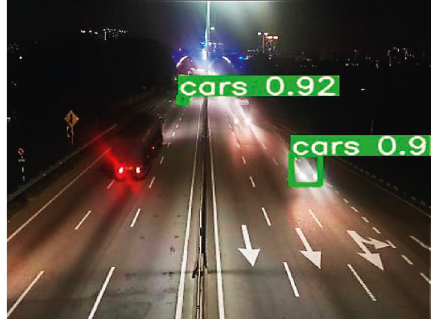
Figure 15: Model is able to detect it accurately in nighttime dataset (B).